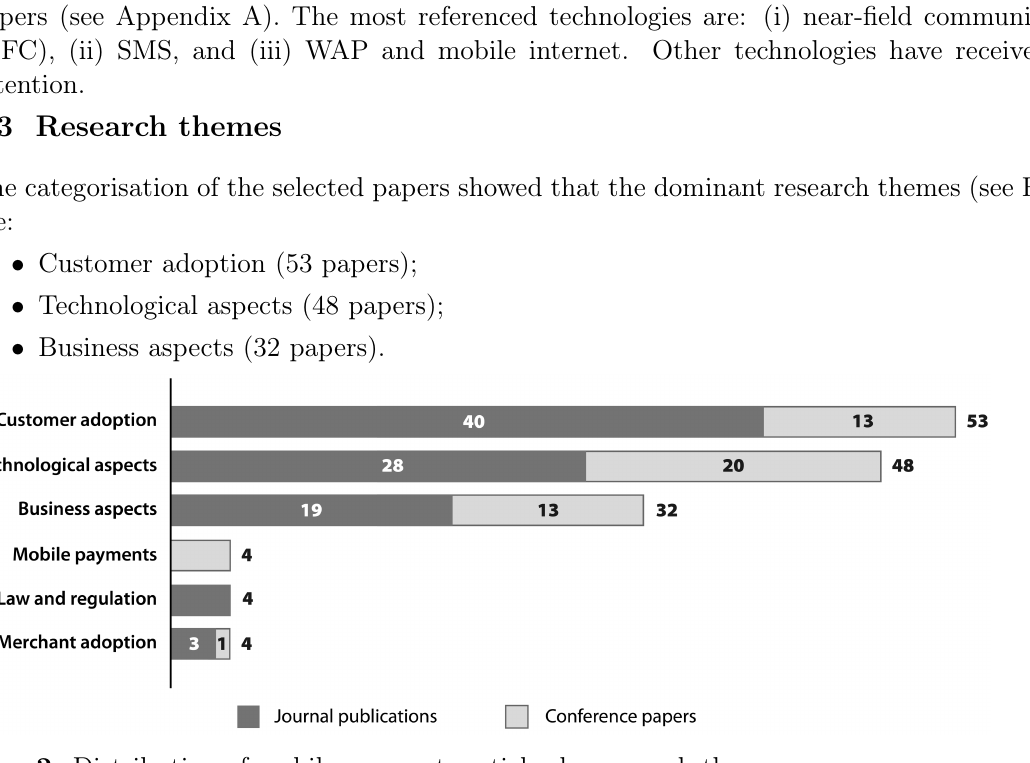
Fig. 2. Distribution of mobile payments articles by research